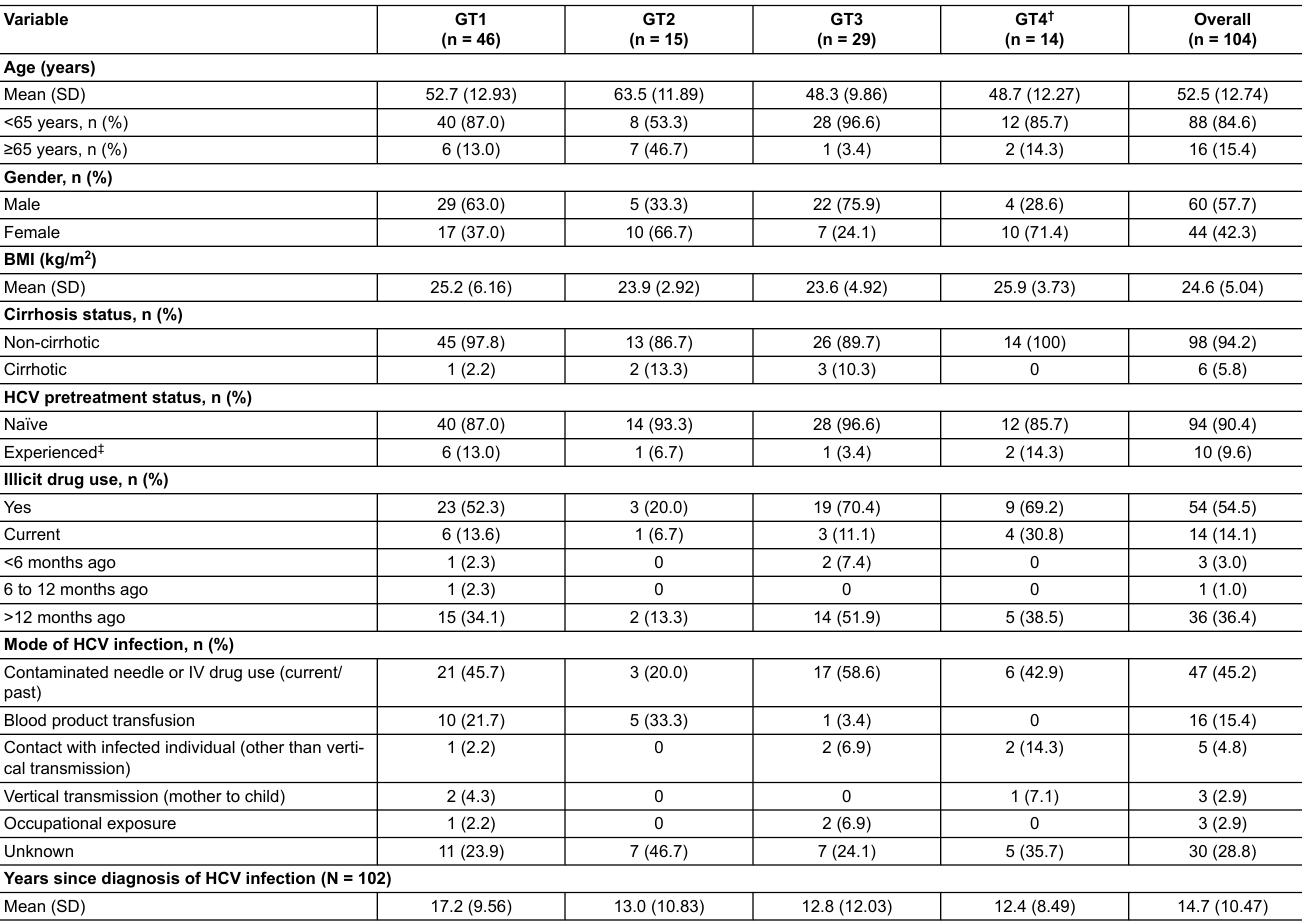
Table S7: Baseline characteristics by HCV genotype (core population, N =